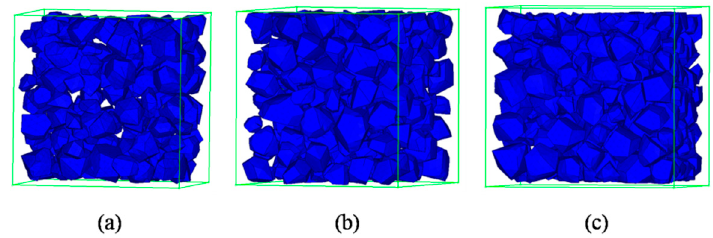
Figure 12. Different aggregate content for cubic specimen: ( a ) 24.96%, ( b ) 37.38%, ( c ) 44.45%.